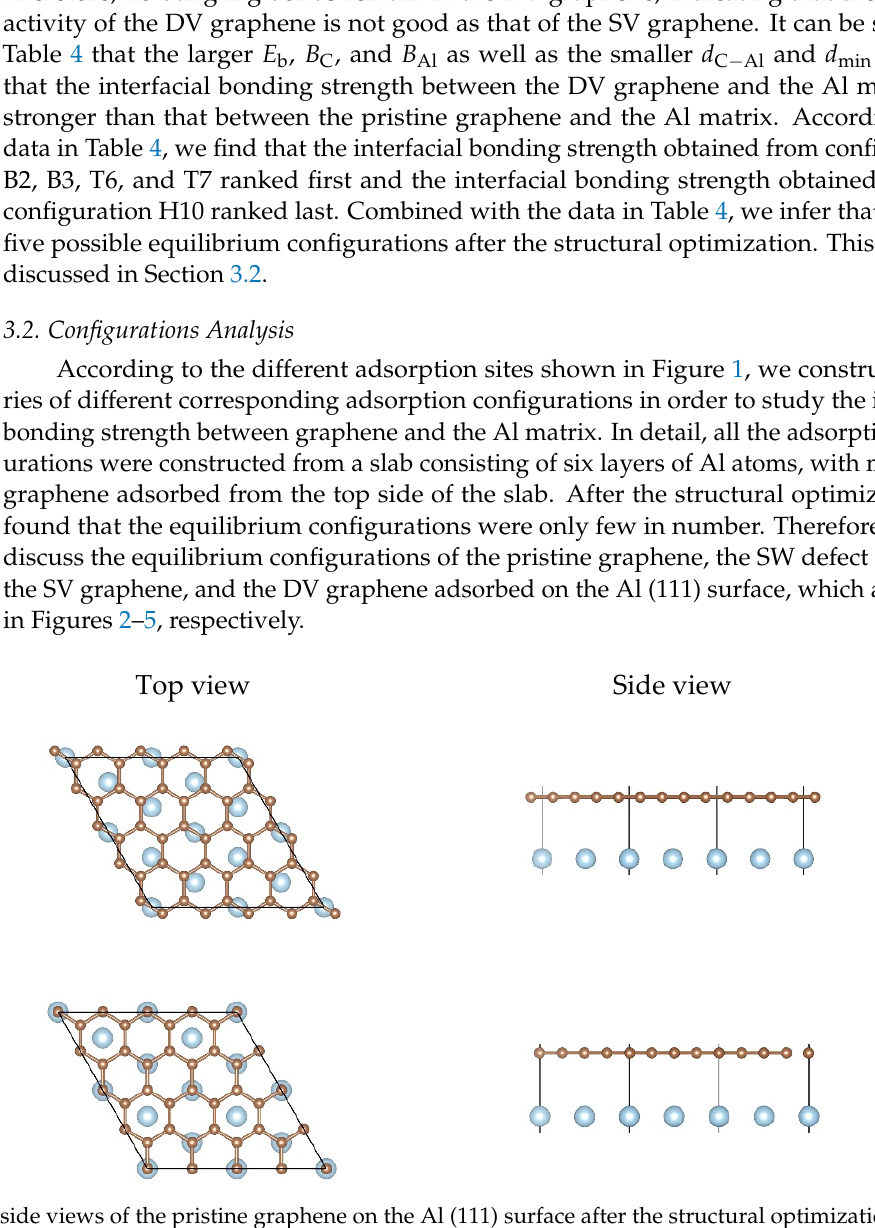
Table 4. The key parameters of the DV graphene/Al (111) interface after optimization. Type